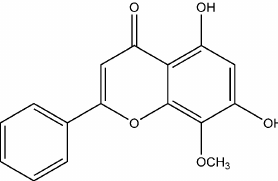
Figure 4. Chemical structure of dihydroxy-8-methoxyflavone (wogonin).